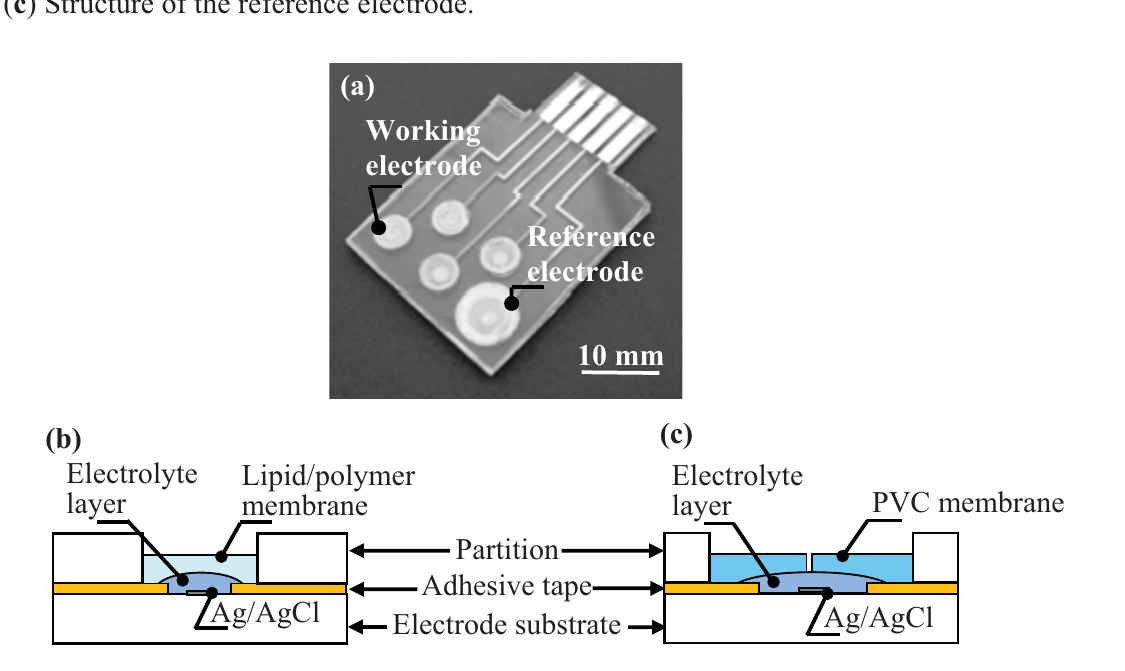
Figure 1. ( a ) Fabricated taste sensor chip. ( b ) Structure of the working electrode. ( c ) Structure of the reference